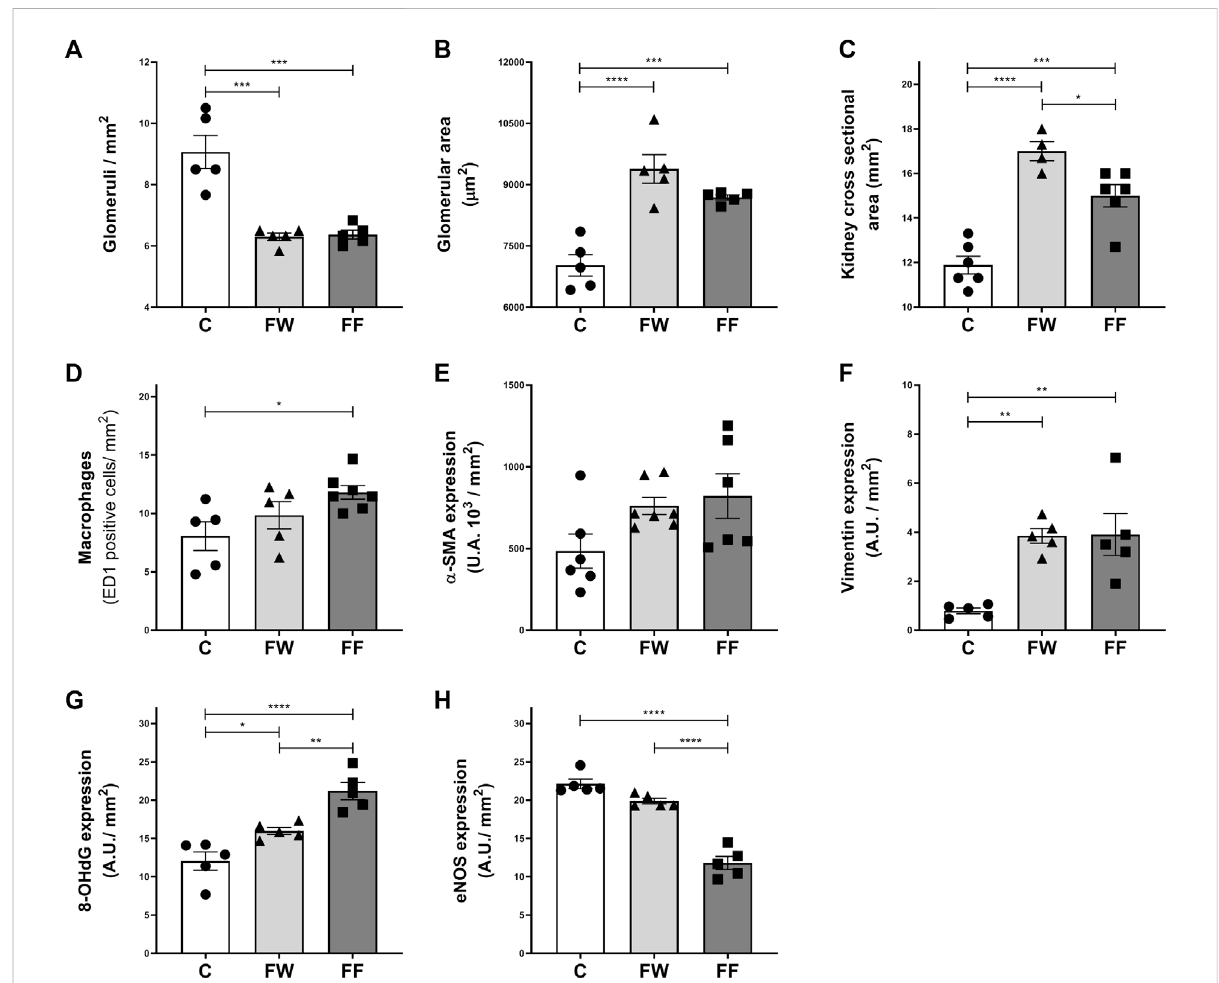
FIGURE 1 Kidney morphological parameters and expression of markers of renal dysfunction: Number of glomeruli/mm 2 (A) ; glomerular area (B) ; kidney cross 398 sectional area (C) ; macrophages (D) and expression of α -SMA (E) , vimentin (F) , 8-399 OHdG (G) and eNOS (H) . Signi fi cance level: ANOVA followed by Bonferroni; values are means ± standard error, 5 – 6 animals per group. * p ≤ 0.05; ** p ≤ 0.01; *** p ≤ 0.001; **** p ≤